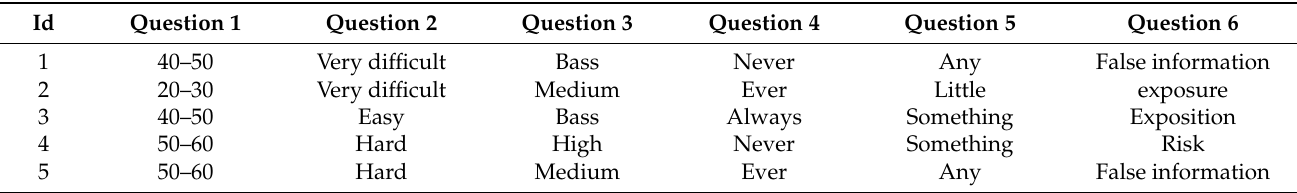
Table 1. Example of responses obtained in a traditional survey.